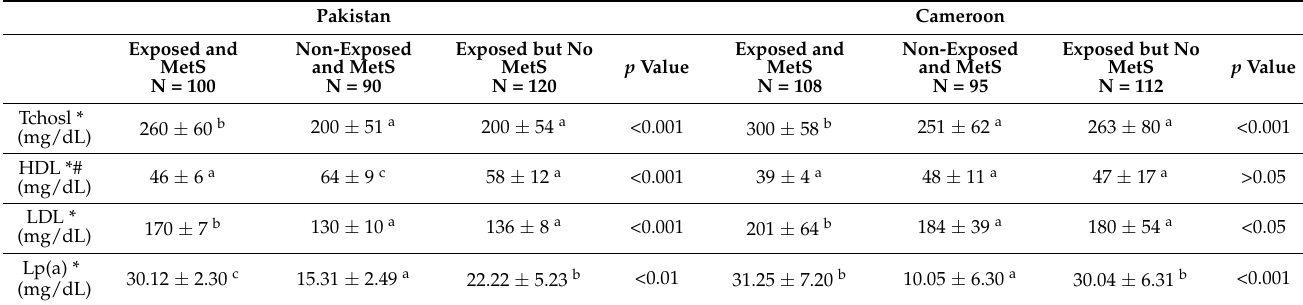
Table 3. Lipid profile of the OPPs exposed and nonexposed groups in two populations. Pakistan